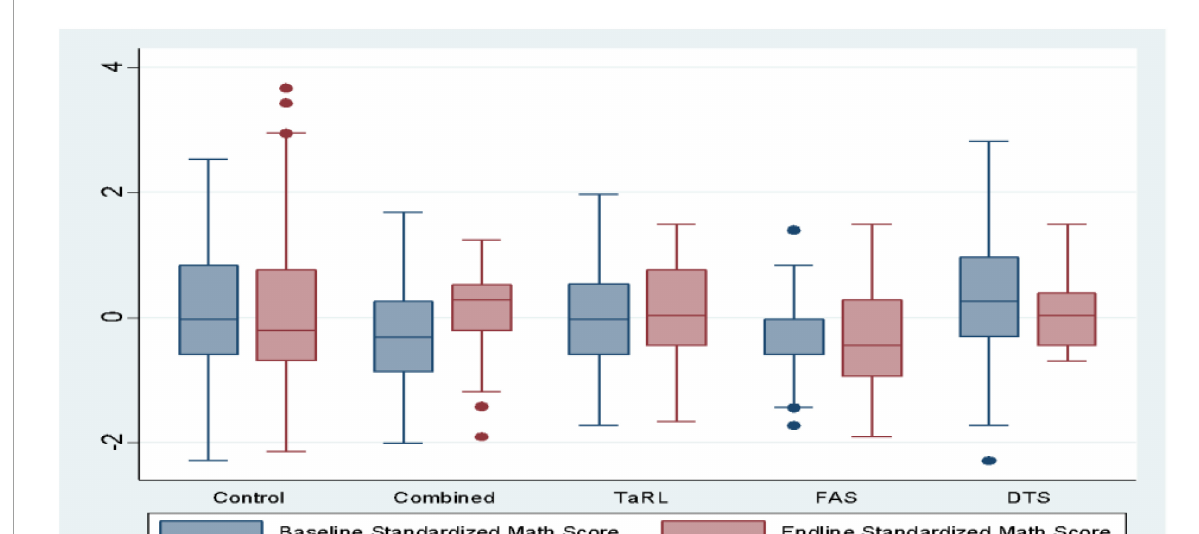
FIGURE10 Standardized English scores before and after interventions.